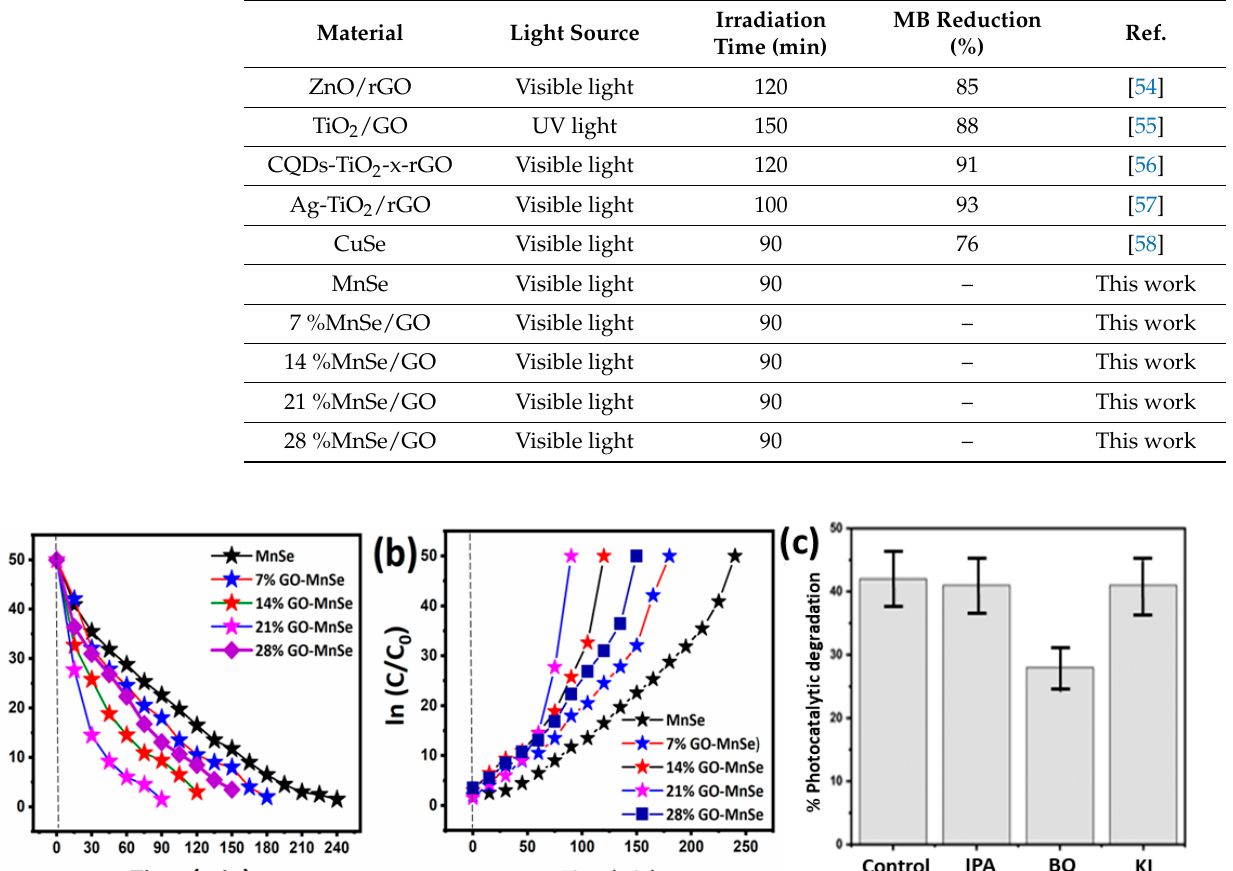
Table 1. Comparison of our work with other previously reported literature.